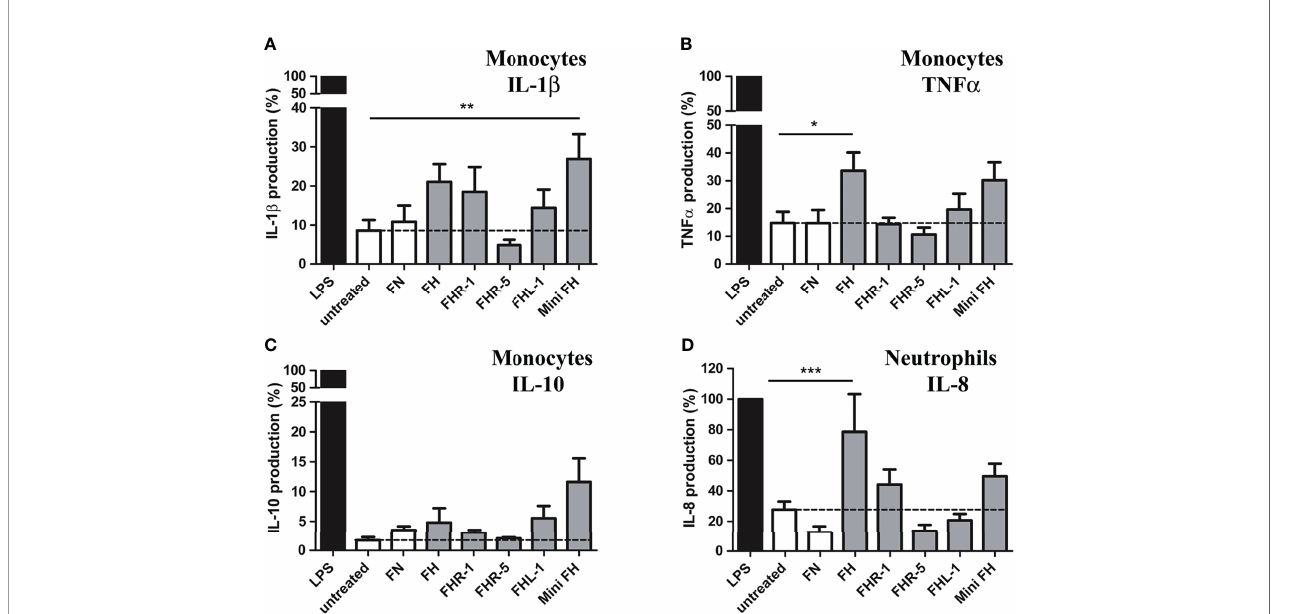
FIGURE 6 | FH family members in fl uence the cytokine pro fi le of monocytes and neutrophil granulocytes. Cells were incubated in the presence or absence (untreated sample) of 300 nM immobilized FH, FHR-1, FHR-5, FHL-1 and mini-FH for 24 h, and IL-1 b (A) , TNF a (B) , and IL-10 (C) secretion of monocytes and IL-8 secretion of neutrophils (D) were investigated by ELISA. As a positive control, cells were activated with LPS; 300 nM fi bronectin (FN) was also used as an additional immobilized control protein unrelated to the FH family. Data represent mean + SEM of nine independent donors. Differences compared to untreated samples with p < 0.05 were considered statistically signi fi cant (one-way ANOVA with Bonferroni ’ s multiple comparison test, * p < 0.05, ** p < 0.01, *** p <